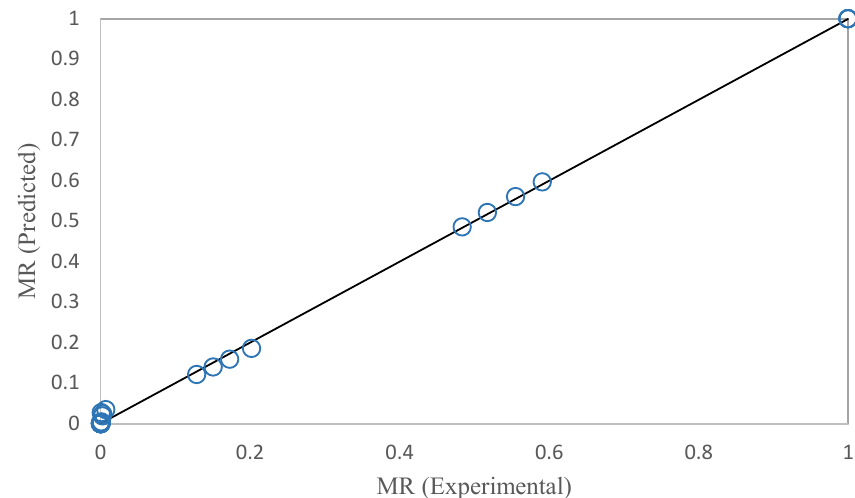
Fig. 3. Comparison of predicted moisture ratio using Page correlation versus experimental moisture ratio at different temperatures.